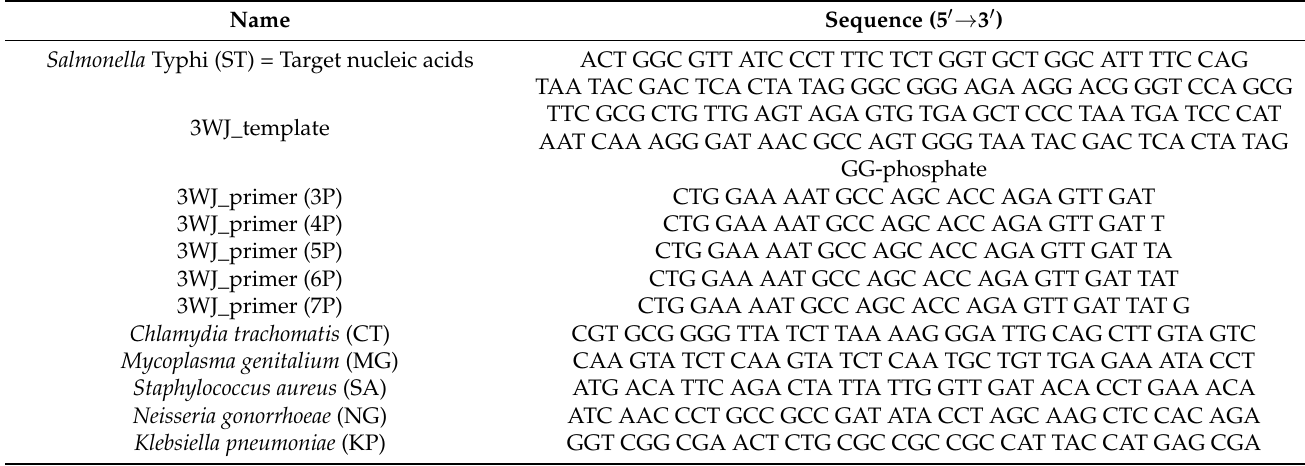
Table 1. Oligonucleotide sequences used in this